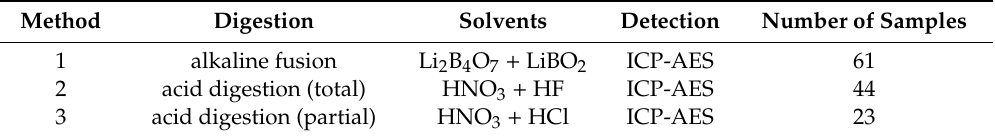
Table 1. Laboratory methods. Overview of various laboratory methods used to determine elemental concentrations of the soil database. Figure 1 shows the method used for every sample. ICP-AES = inductively coupled plasma atomic emission